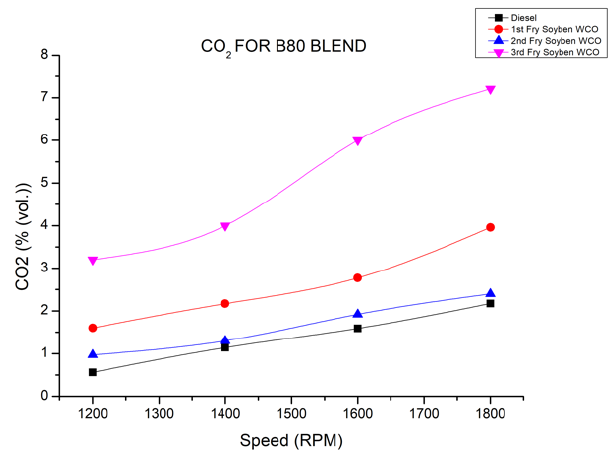
Figure 7. CO 2 emission of different fry oils (B80 blend) at different rpm.